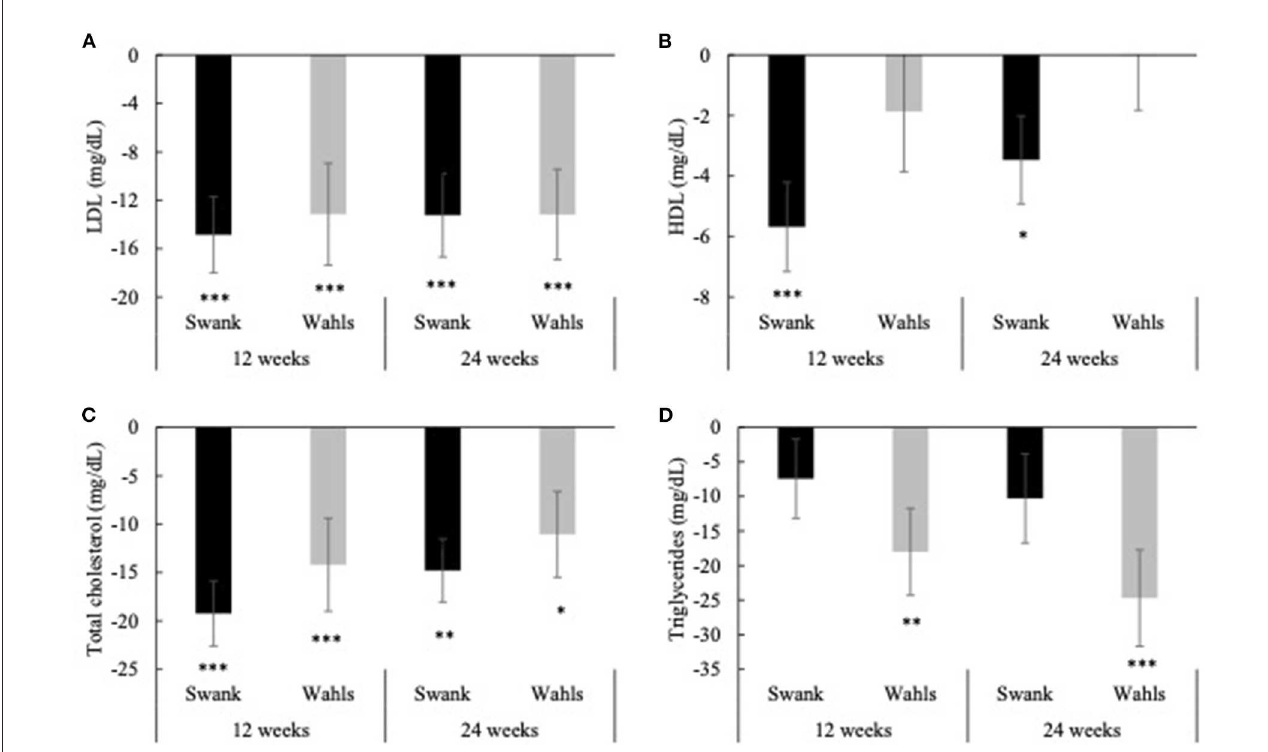
FIGURE3 Mean change from baseline for (A) LDL, (B) HDL, (C) total cholesterol, and (D) triglycerides at 12- and 24-weeks for the Swank (black bars) and Wahls (gray bars) groups. Statistical significance was determined by generalized linear mixed models and represented by * p ≤ 0.05, ** p ≤ 0.01, and *** p ≤